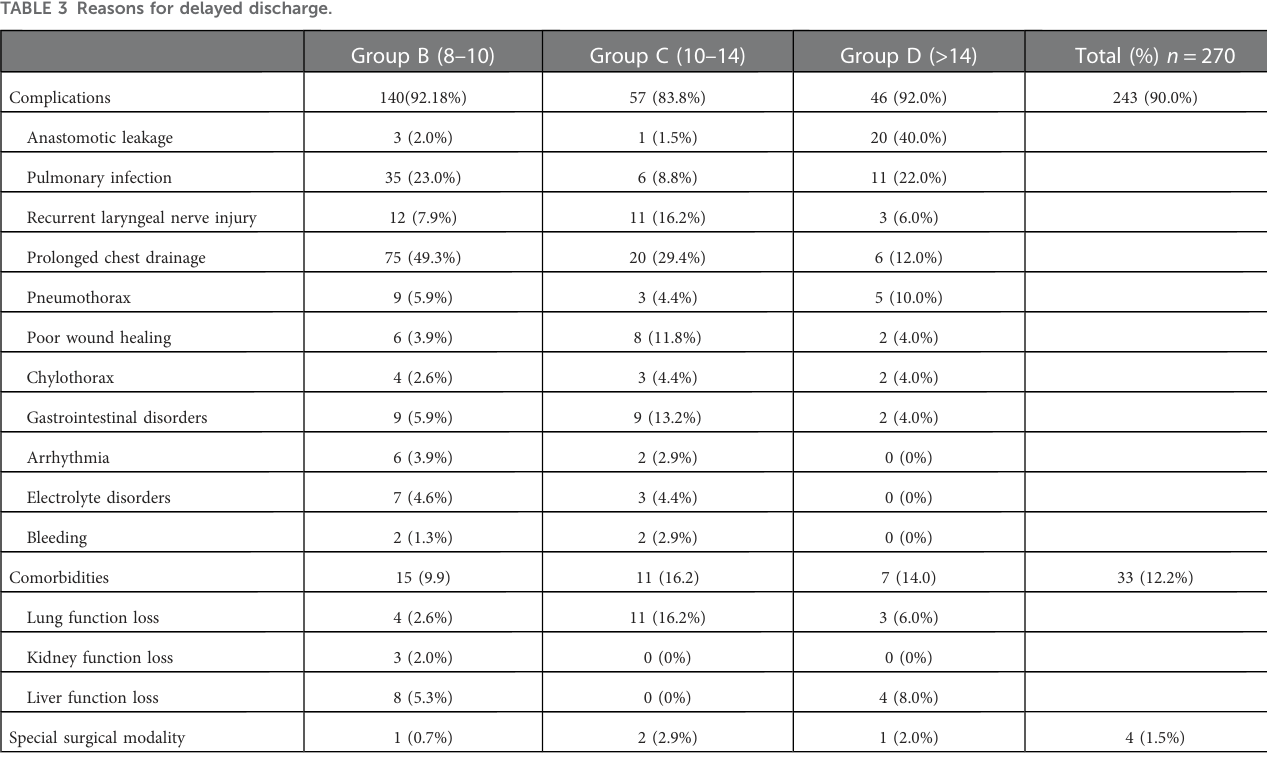
TABLE 3 Reasons for delayed